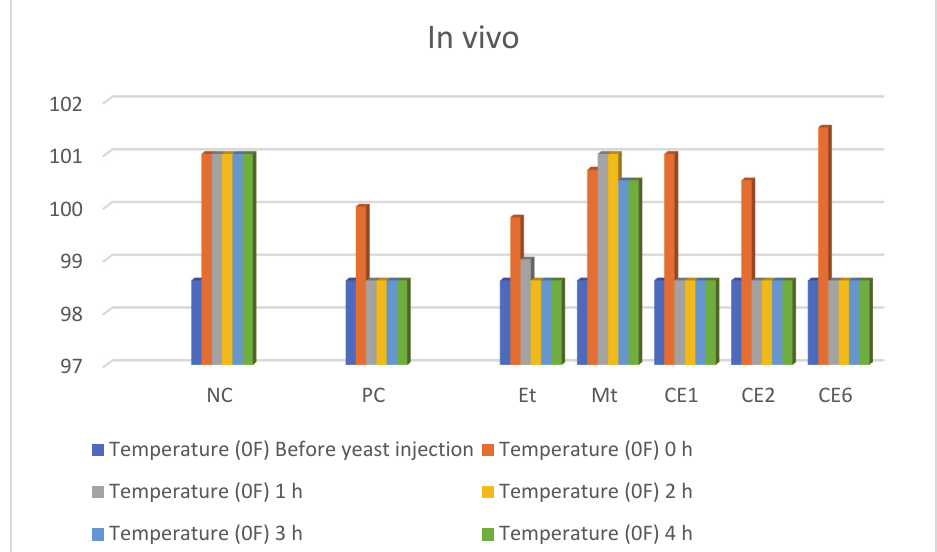
Figure 8. Graphical representation of in vivo anti-pyretic activity.